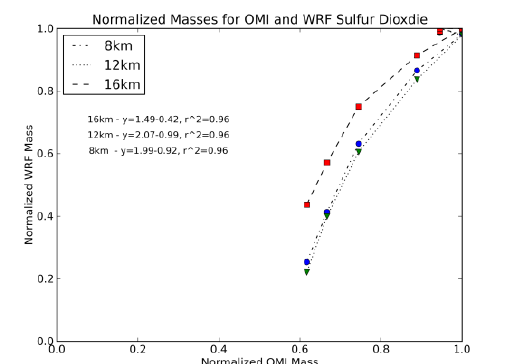
Figure 3: Correlation between WRF-Chem (y-axis) and literature OMI (x axis) SO 2 domain masses for 8, 12 and 16 km plume